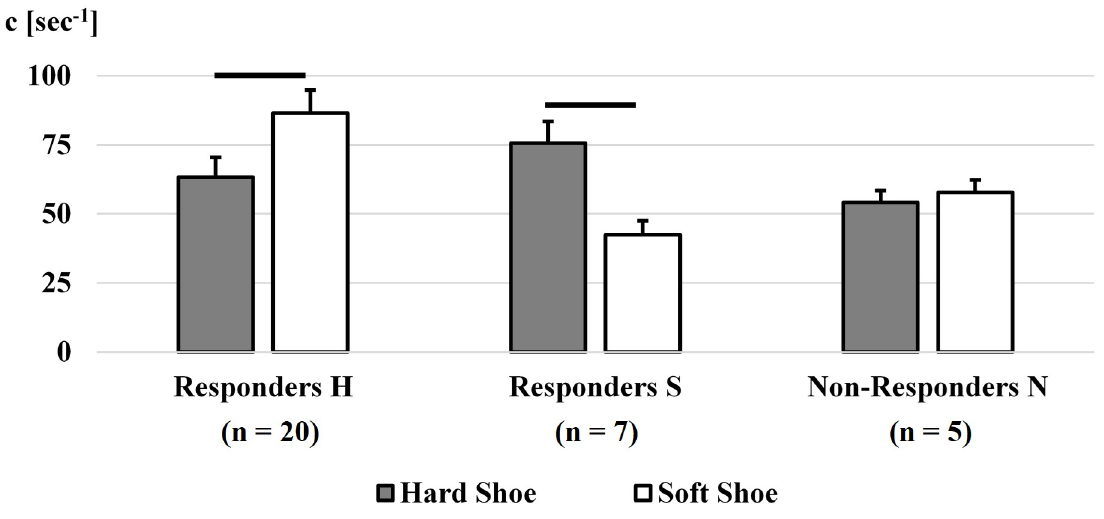
Fig 3. Group comparison of damping coefficient. Mean ± se of damping coefficients (c) per group according to shoe conditions (hard and soft) with the minimal damping coefficient for the gastrocnemius medialis. Significance is indicated as a black bar.